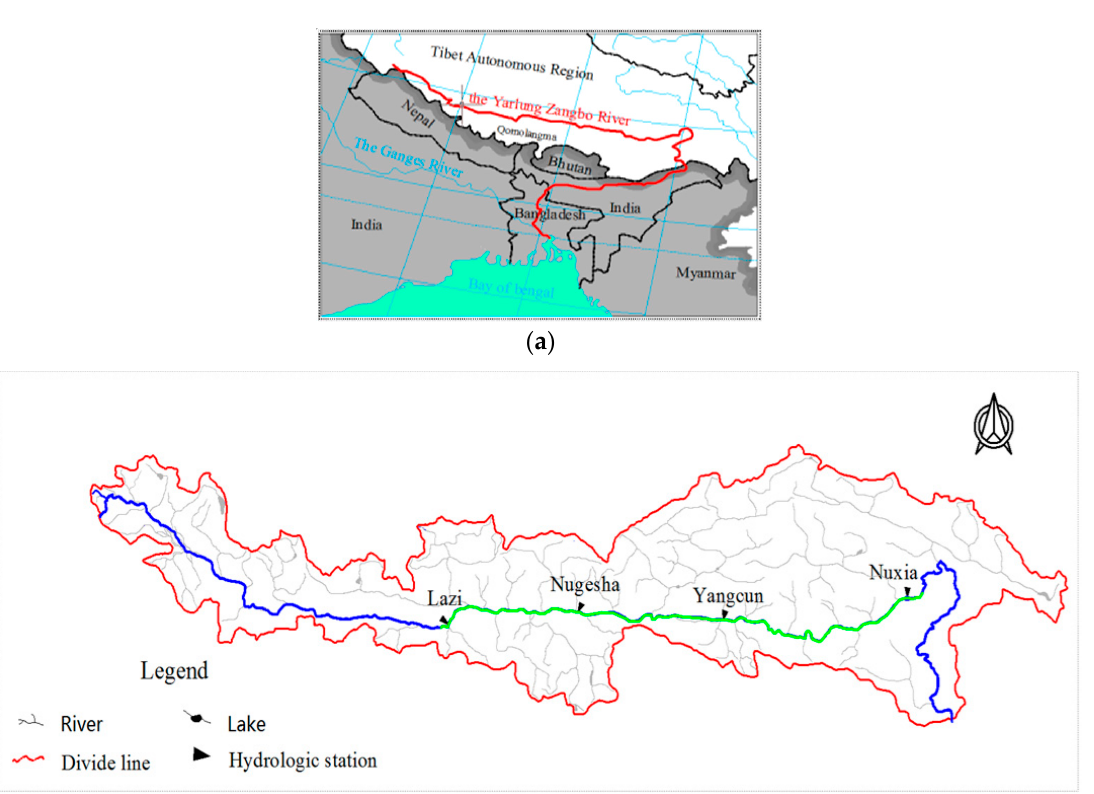
Figure 1. ( a ) Geographic location of the study area; ( b ) The water system map of the Yarlung Zangbo River basin. The green line is the midstream region of this river, and the blue line is the upstream and downstream region of this river.